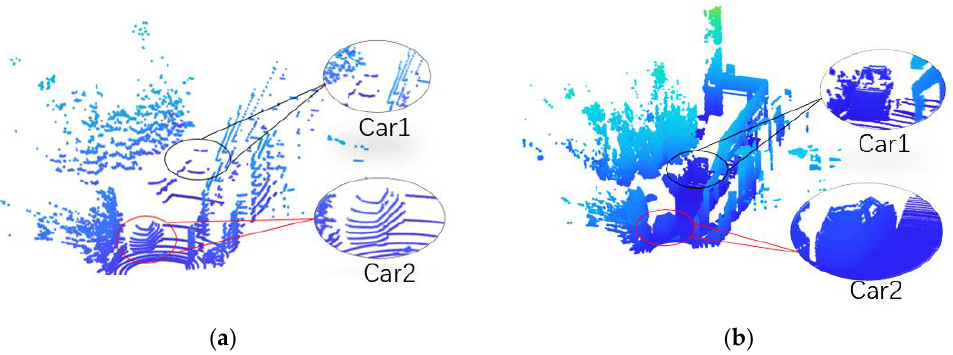
Figure 2. Comparison between point clouds with and without dense scanning system: ( a ) Original LiDAR point cloud from 16-line 3D LiDAR; ( b ) Point cloud with the dense scanning system.